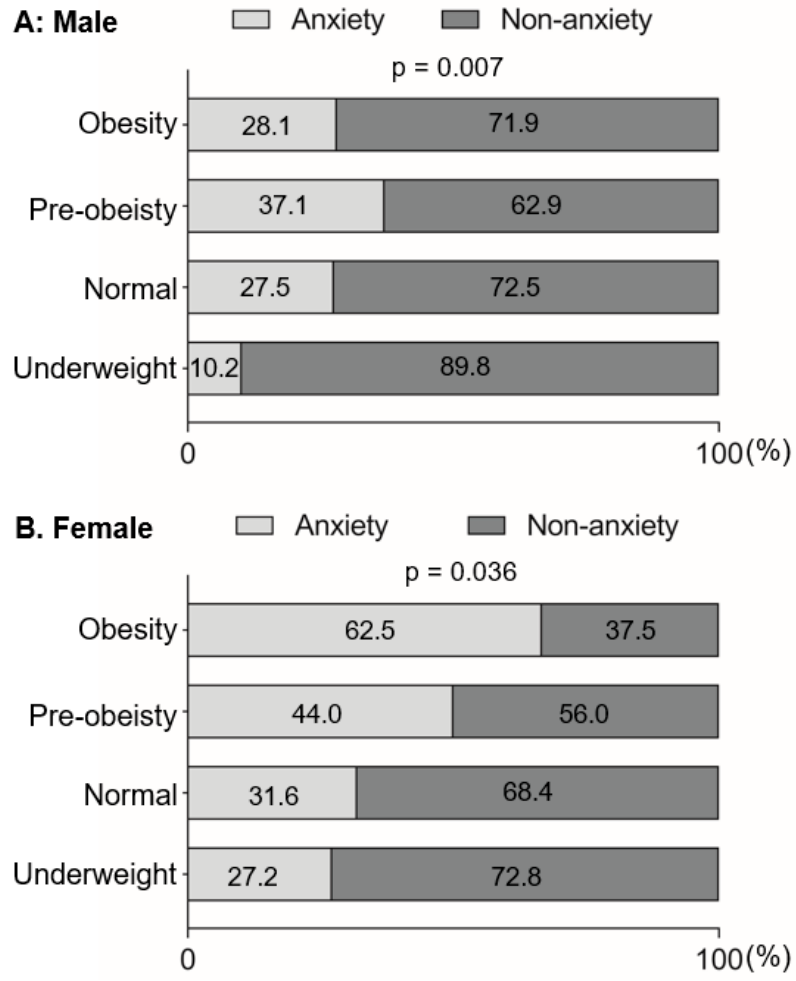
Figure 2. Baseline anxiety distribution among underweight, normal-weight, pre-obese and obese students in males ( A , B ) females. Dark and pale gray bars indicate the proportion of non-anxiety and anxiety, respectively. Table 2. Results of univariate logistic regression analysis for the association between anxiety and obesity.